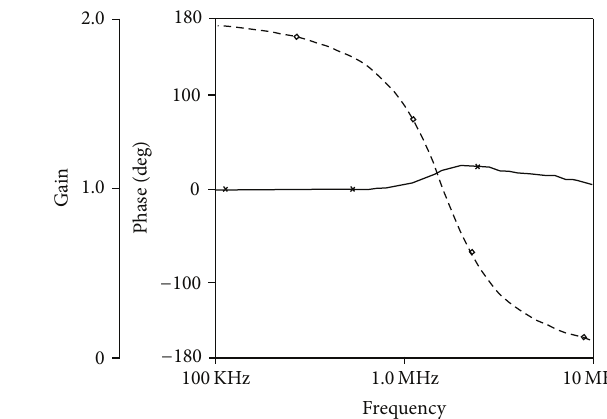
Figure 6: Simulated low pass, band pass, and high-pass responses.